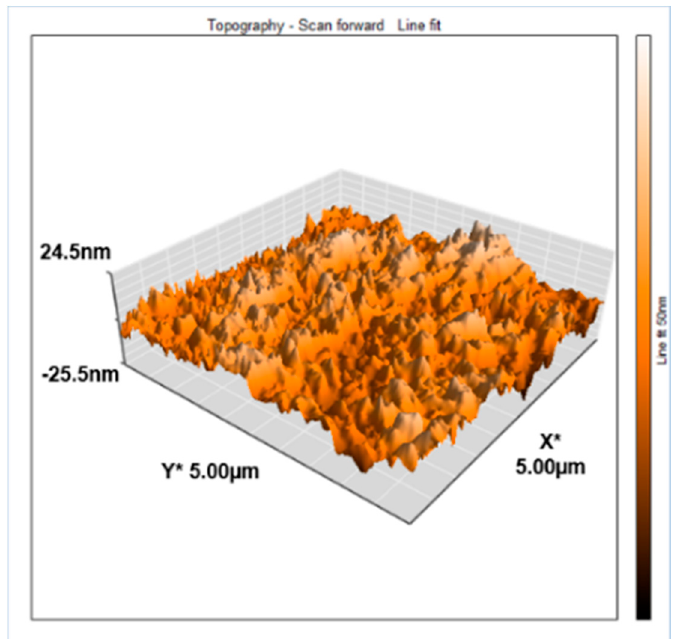
Figure 6. 3D AFM image of the control membrane.